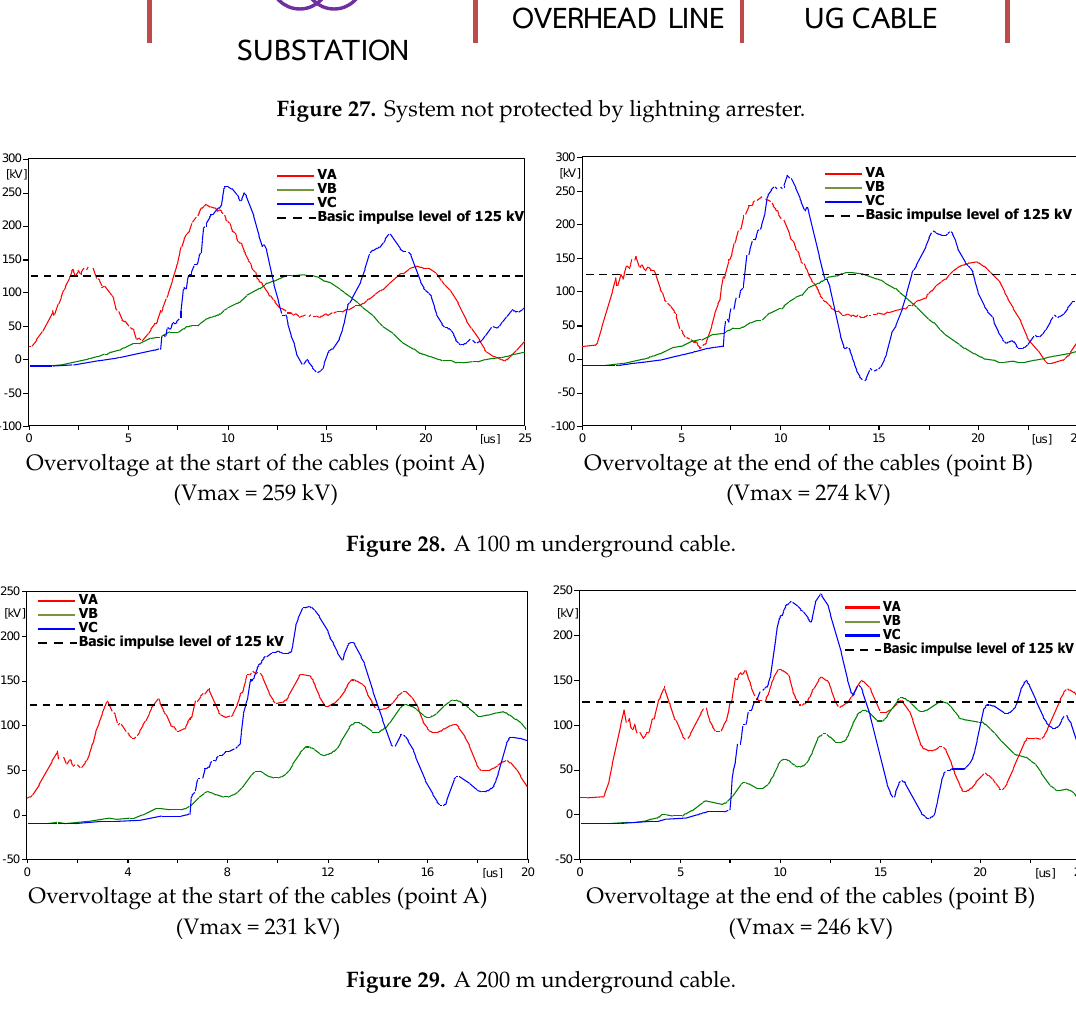
Figure 29. A 2 00 m underground cable. Figure 29. A 200 m underground